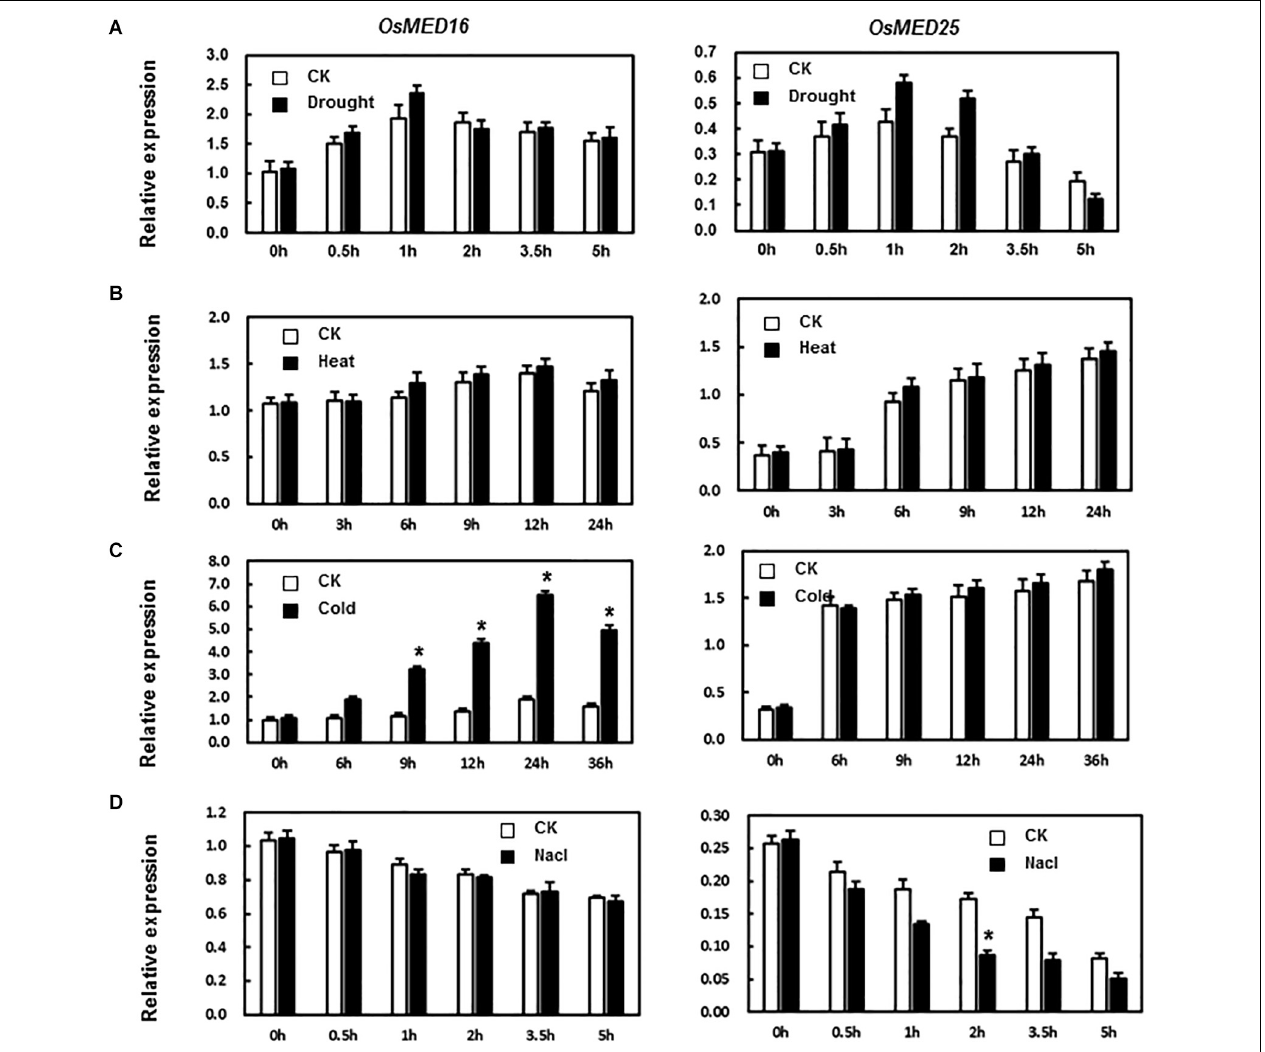
FIGURE 3 | The expression patterns of OsMED16 and OsMED25 genes in response to drought, heat, cold, and NaCl stress. (A) The expression patterns of OsMED16 and OsMED25 under drought stress. (B) The expression patterns of OsMED16 and OsMED25 under heat stress. (C) The expression patterns of OsMED16 and OsMED25 under cold stress. (D) The expression patterns of OsMED16 and OsMED25 under NaCl stress. The samples were collected at different time points for analysis of gene expression by qRT-PCR. Expression data were normalized against OsActin gene as the reference, and the relative expression is shown as fold expression of OsActin . Data are presented as means ± SD from three independent experiments, and * above the columns indicate significant differences at p < 0.05 between the treated plants and the control.